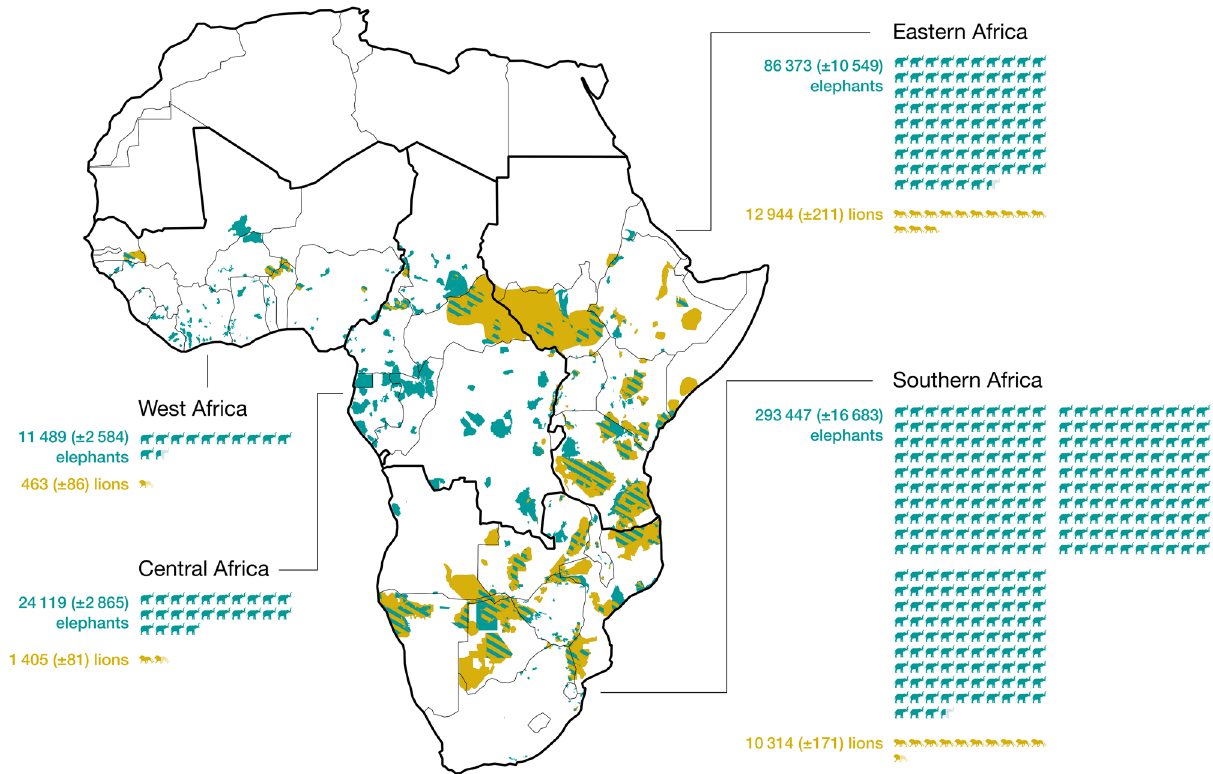
Fig. 1 Distribution of African lions ( Panthera leo ) and African elephants ( Loxodonta Africana and Loxodonta cyclotis ), and regional contribution to their conservation. Lion ranges are in orange, whereas elephant ranges are in turquoise. Areas hatched in orange and turquoise represent overlapping species ranges. Each animal icon is equivalent to 1000 individuals. Values in parenthesis refer to 95% con fi dence intervals. Silhouette for lion is in the public domain and available from phylopic.org and silhouette for elephant is free for personal and commercial purpose from www. fl